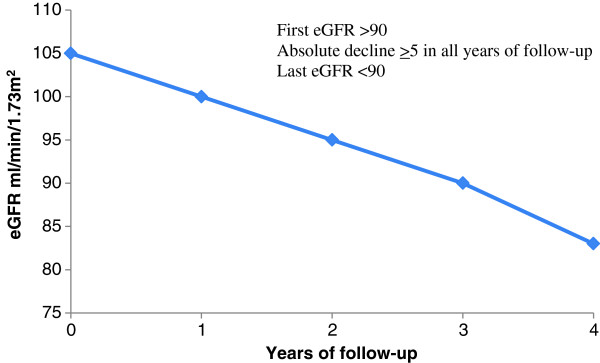
RP definition B.